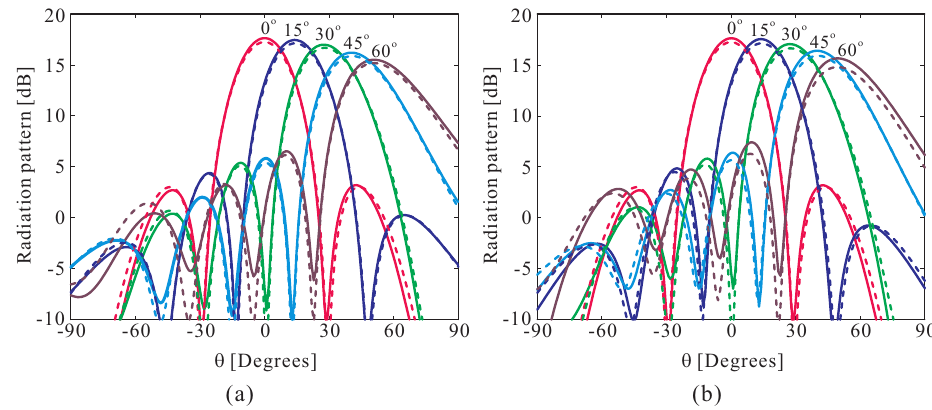
Figure 8. Simulated radiation patterns of the 5 × 5 CP RDA arrays with EBGs (solid line curve) and without EBGs (dashed line curve) at 5.2 GHz: ( a ) xz -plane and ( b ) yz